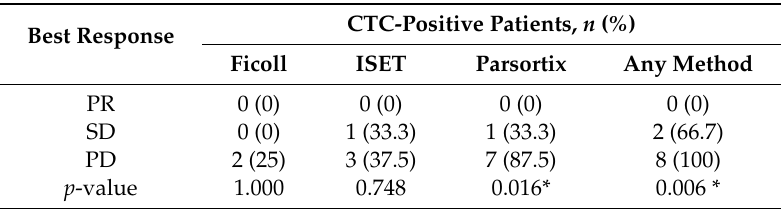
Table 3. CTC detection using di ff erent approaches according to best response to anti-programmed cell death-1 (PD-1)